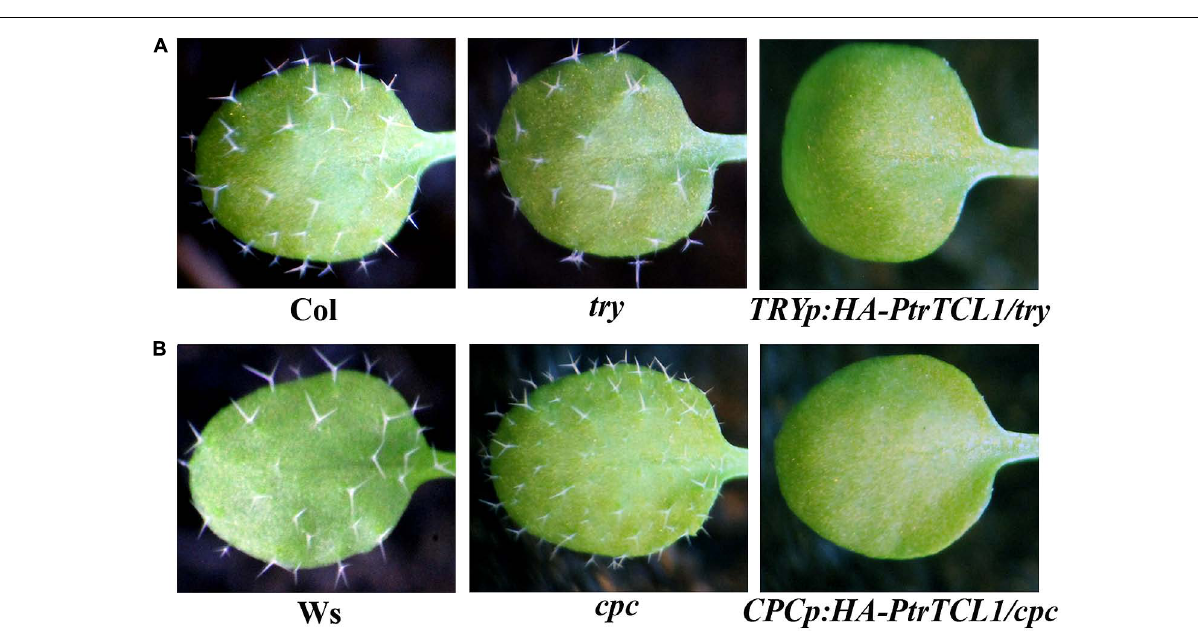
FIGURE 7 | Expression of PtrTCL1 in try and cpc resulted in glabrous phenotypes. (A) Expression of PtrTCL1 under the control of TRY native promoter in the try mutant background resulted in glabrous phenotype.